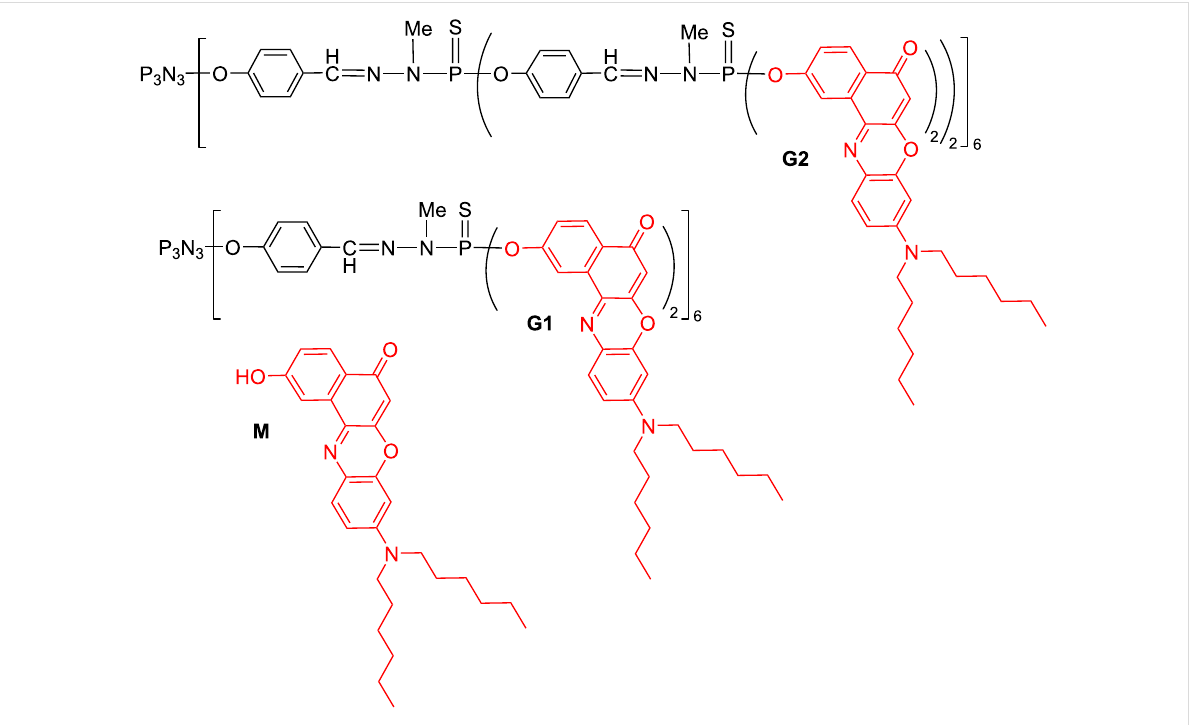
Figure 5: Nile Red derivatives: monomer (M) and two generations of dendrimers.